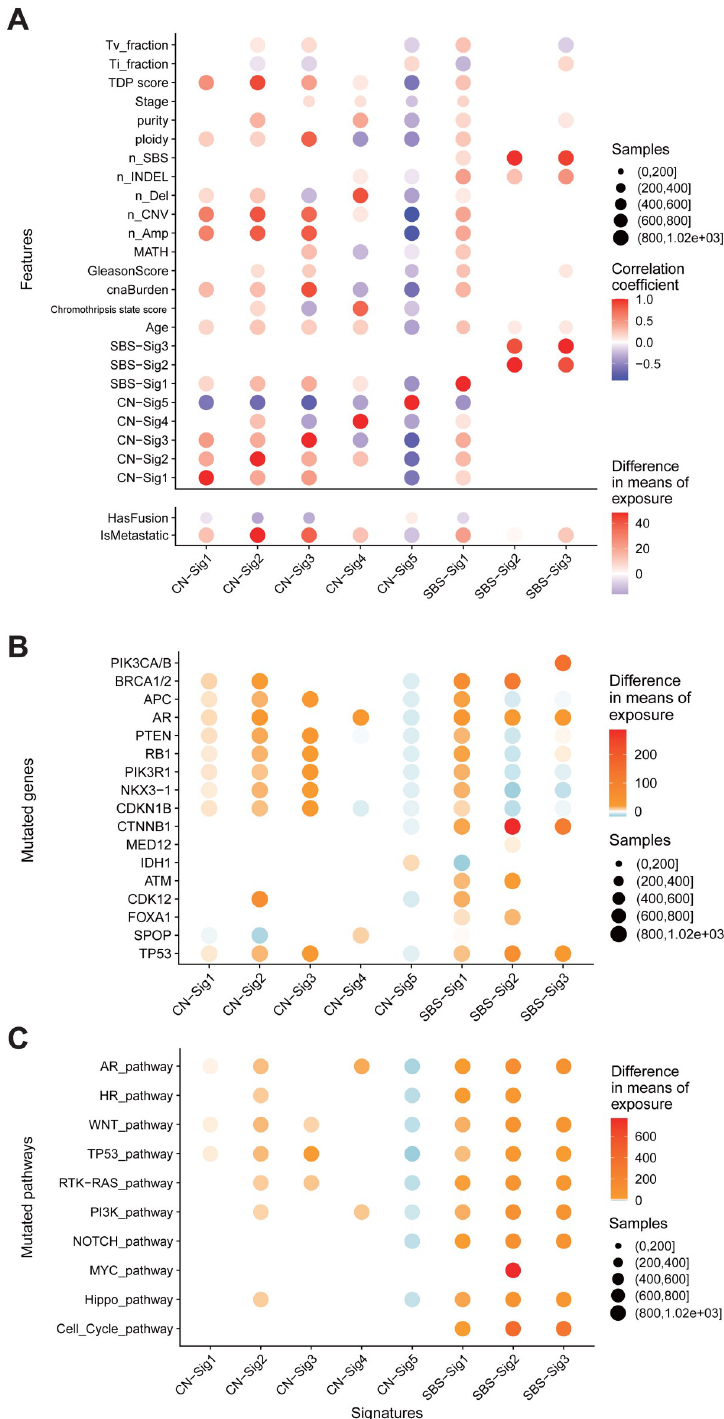
Fig 4. Genome alteration signatures and mutational processes in PC. (A) Associations between the exposures of genome alteration signatures and features including clinical parameters, somatic DNA alteration quantifications. (B,C) Associations between the exposures of genome alteration signatures and mutations in selected genes (B) or pathways (C). Only differences with false discovery rate P < 0.05 (Mann–Whitney U-test) are shown. Red, positive correlation; blue, negative correlation. The depths of colors in filled circles indicate the extent of difference. Sizes of circle in all plots indicate the number of cases included in each analysis.